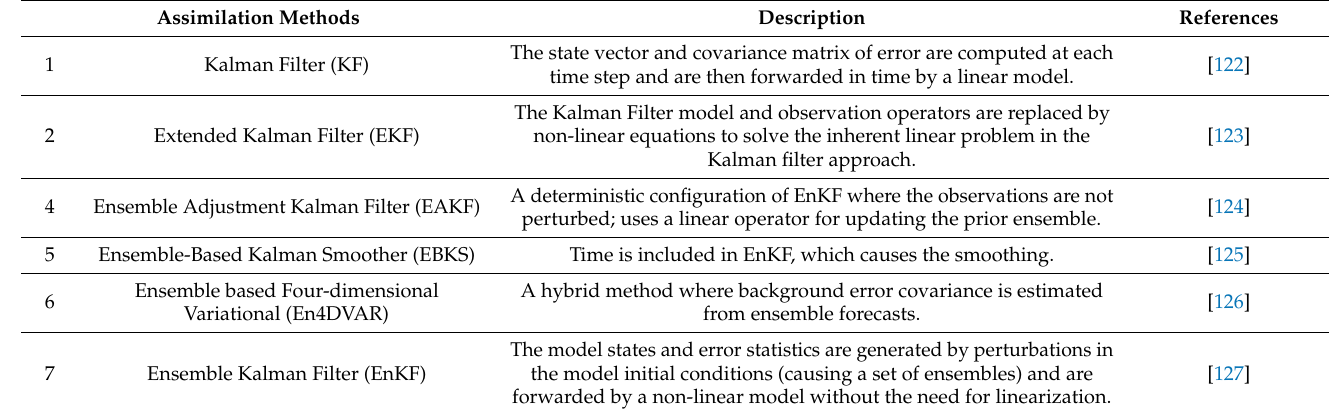
Table 2. Assimilation methods applied in the reviewed papers (from 2005 to